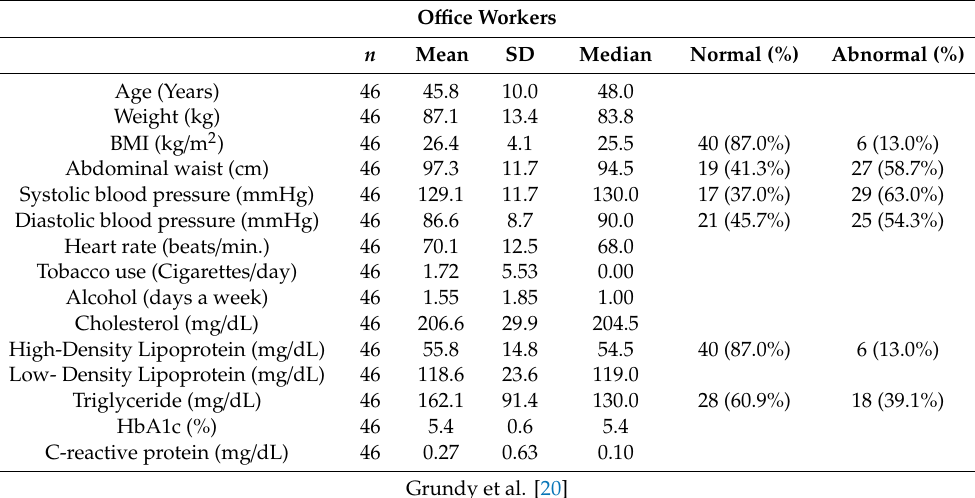
Table 3. Representation of major cardiovascular risk factors in the study population.